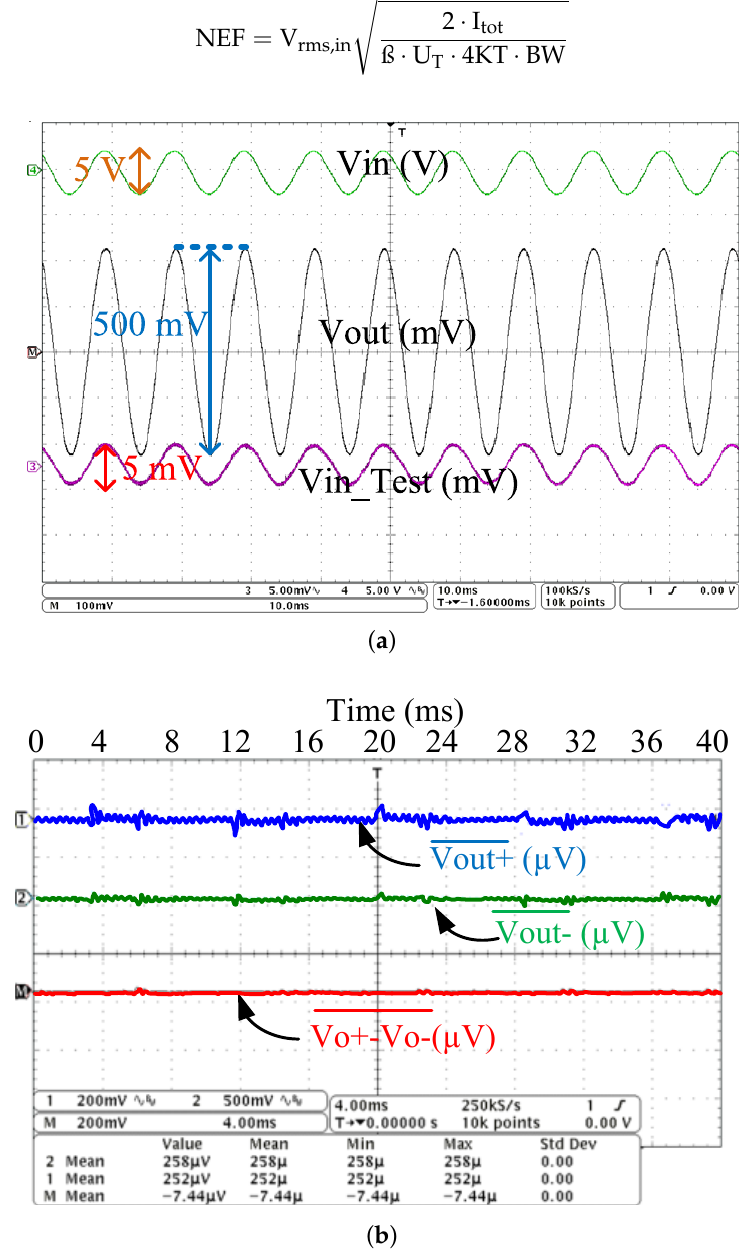
Figure 12. Measured open loop (R load = 10 M Ω and C load = 95 pF): ( a ) voltage gain of the LPGA at 100 Hz for Vin = 5 V PP ; and ( b ) CMRR ( 140 dB) of the LPGA at 100 Hz for Vin = 1 V PP